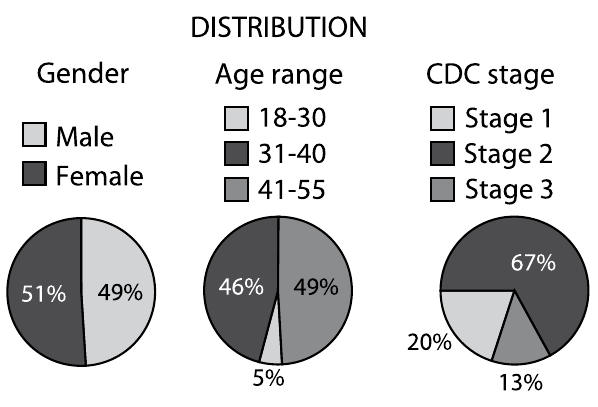
Figure 1: Participant distribution.